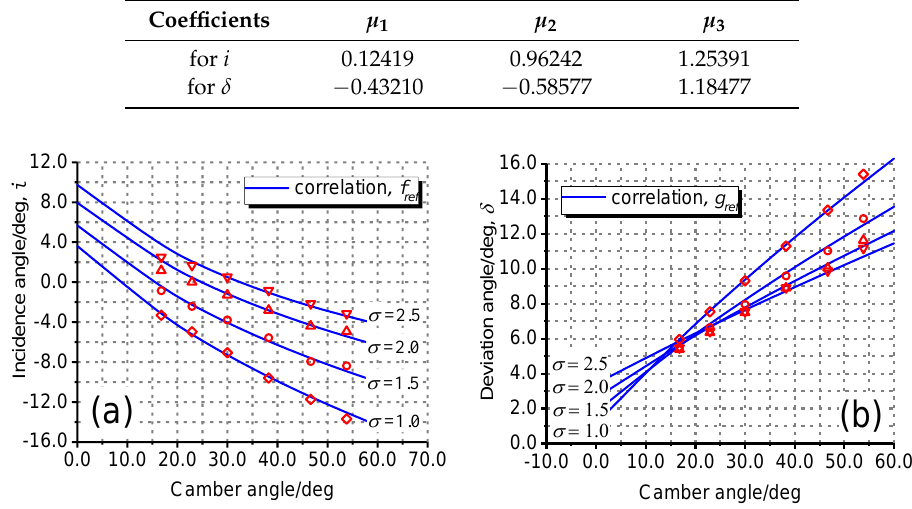
Table 5. Constant coefficients for the correction functions of equivalent conventional blades.